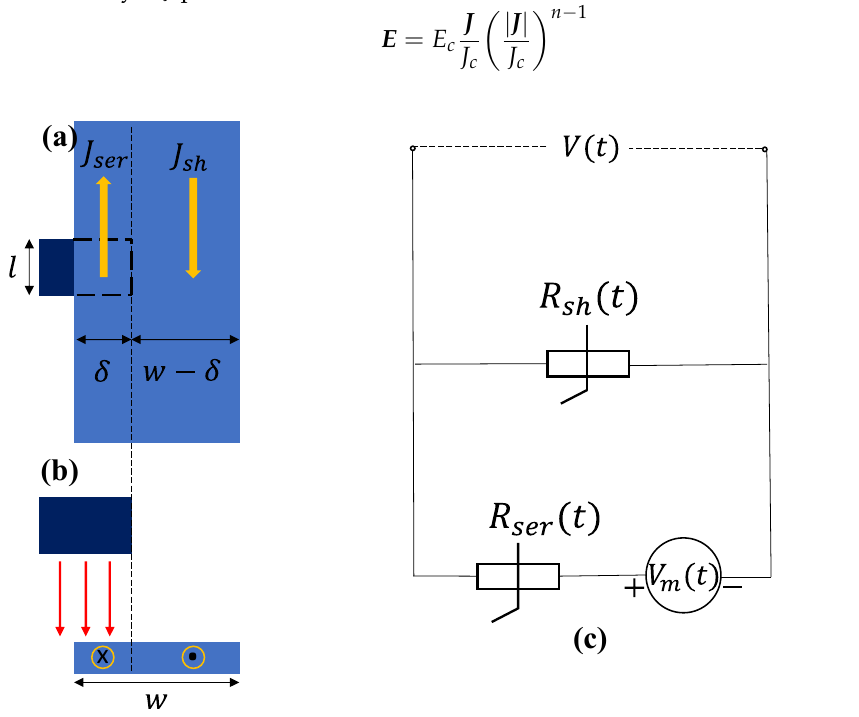
Figure 8. Schematic diagram illustrating the circulating current as the magnet rotates over the HTS tape ( a ) vertical view, ( b ) front view, ( c ) circuit sketch.